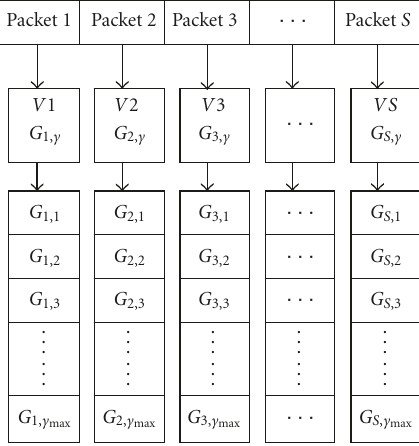
Figure 8: JPEG 2000 data packets and possible gain associated to their protection.